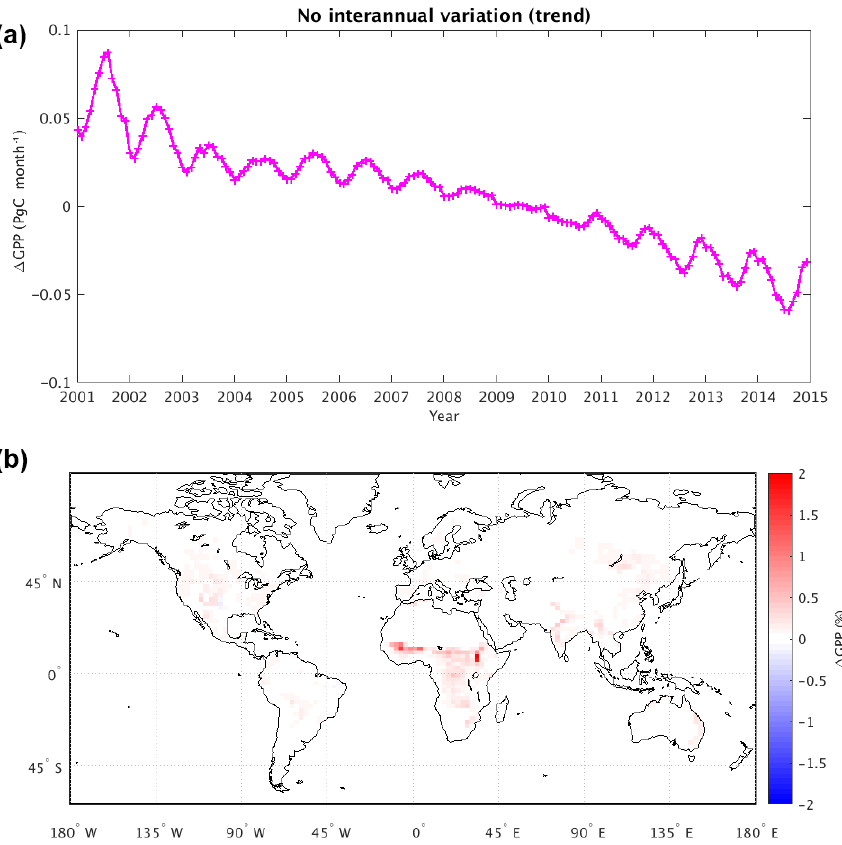
Figure 7. (a) Change in mean global GPP (PgCmonth − 1 ) due to removal of the trend in the interannual variability in atmospheric CO 2 concentration (i.e., GPP from the cCO2 experiment minus that from the magtCO2 experiment). (b) Map of time-averaged GPP changes in percent